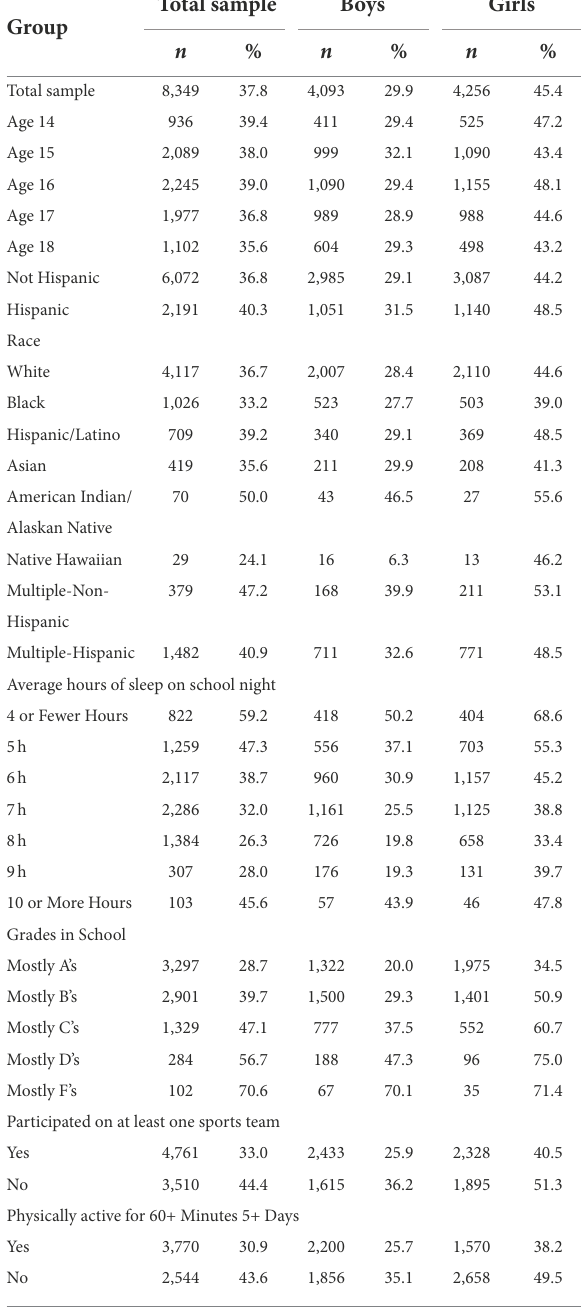
TABLE 2 Percentages of high school students endorsing a significant problem with cognitive functioning.